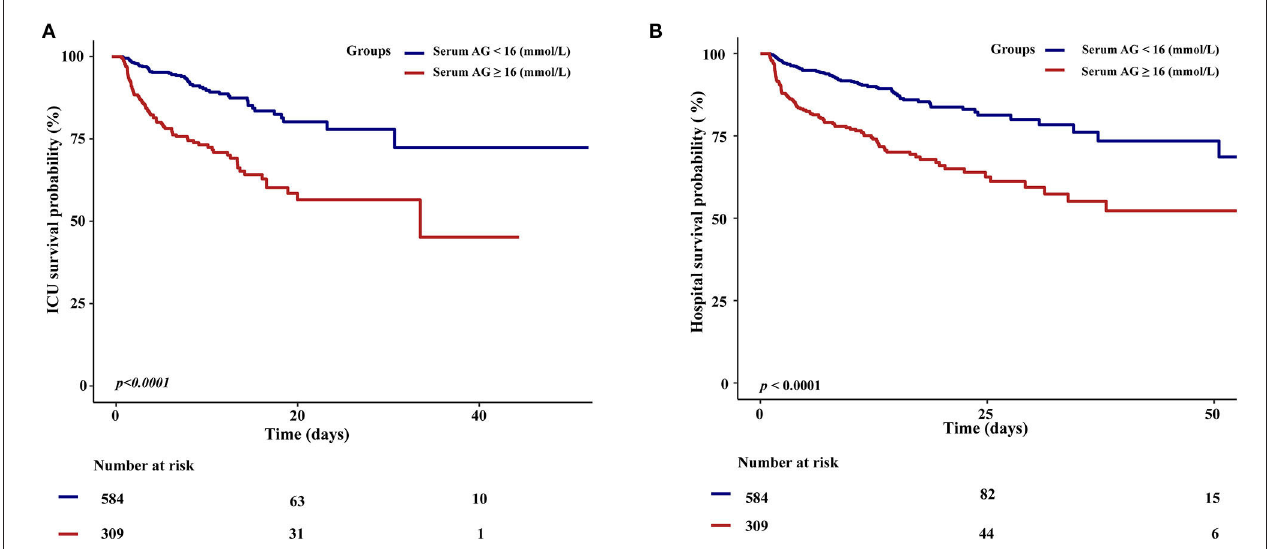
FIGURE 3 | Kaplan–Meier survival curves for critically ill patients with non-traumatic SAH based on serum Anion Gap. (A) ICU all-cause mortality; (B) Hospital all-cause mortality. x -Axis: survival time (days). y -Axis: survival probability.